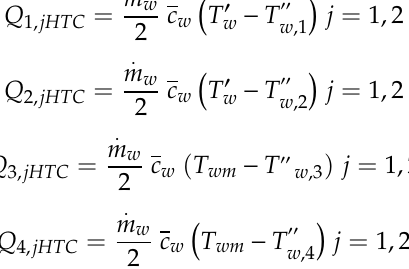
(cid:48) = 14.28 ◦ C and T am